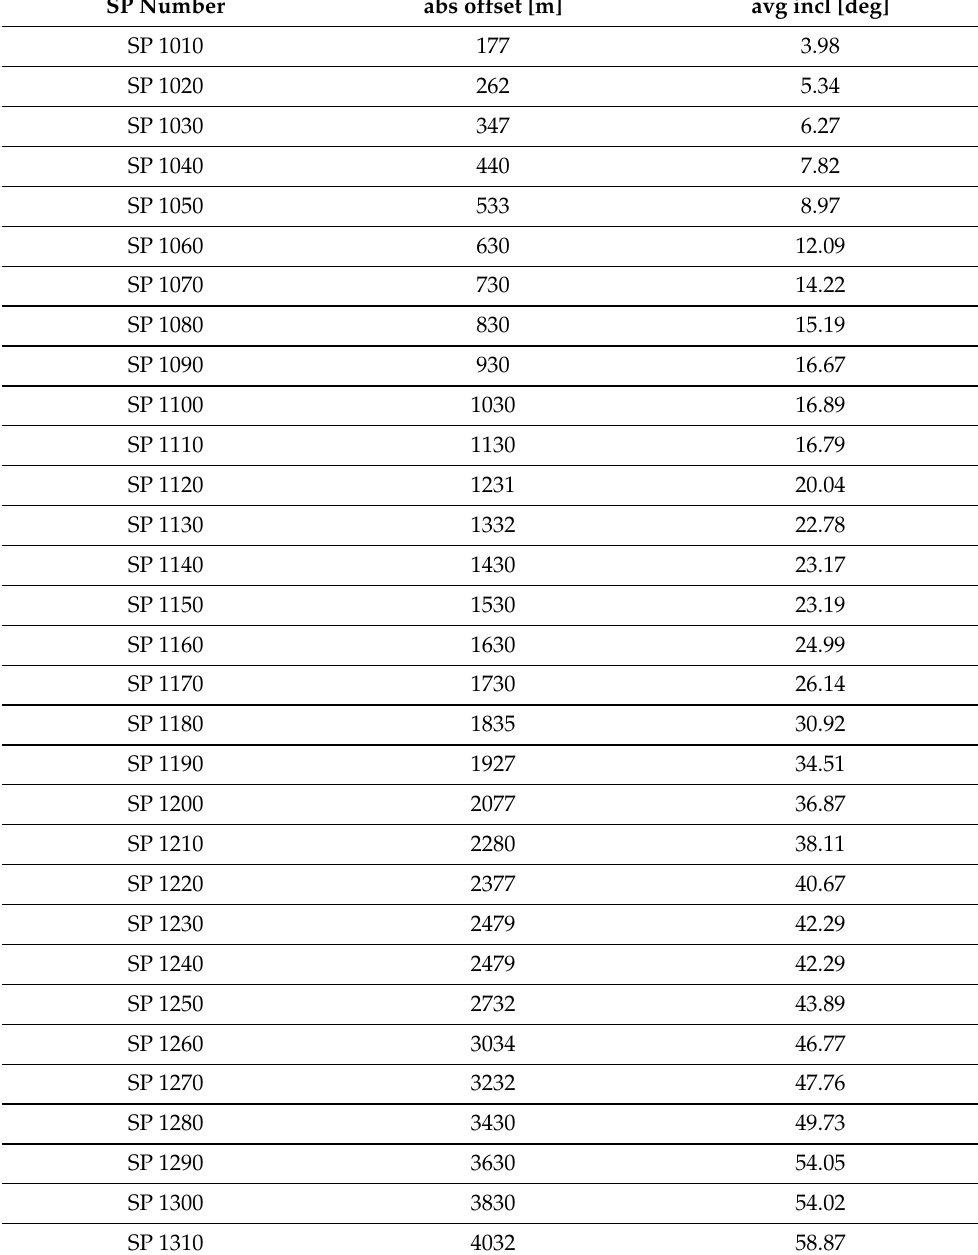
Table 1. List of shot points with their offsets and average polarization angles used for clustering. SP Number abs offset